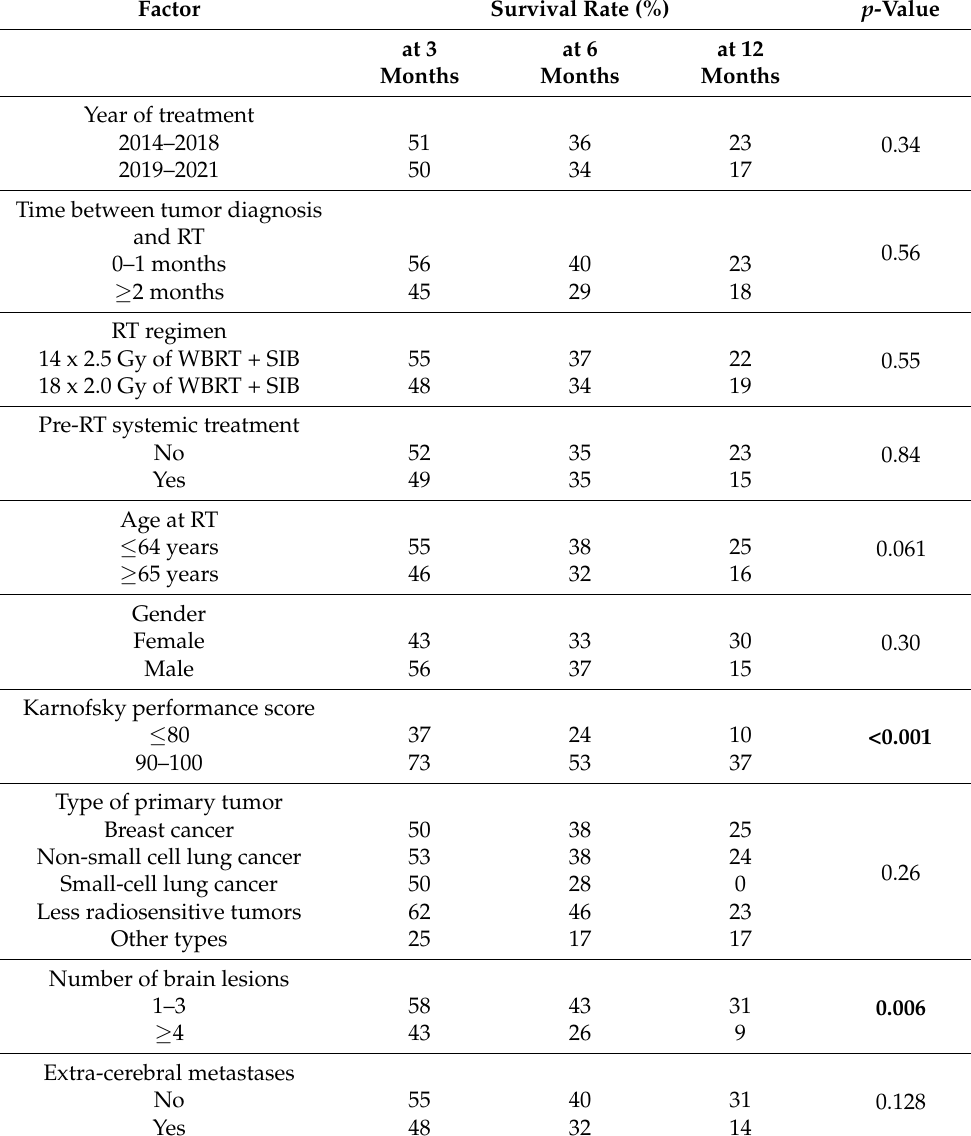
Table 2. Survival rates of the investigated factors at 3, 6, and 12 months following radiotherapy. Factor Survival Rate (%) p -Value at 3 at 6 at 12 Months Months